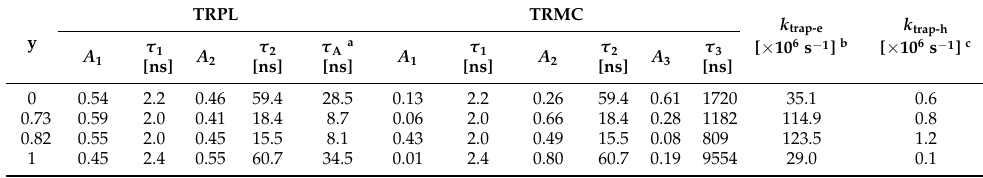
Table 2. Fitting parameters for TRPL and TRMC kinetics of MAPb(Br 1 − y I y ) 3 single crystals with dif- ferent Br compositions.